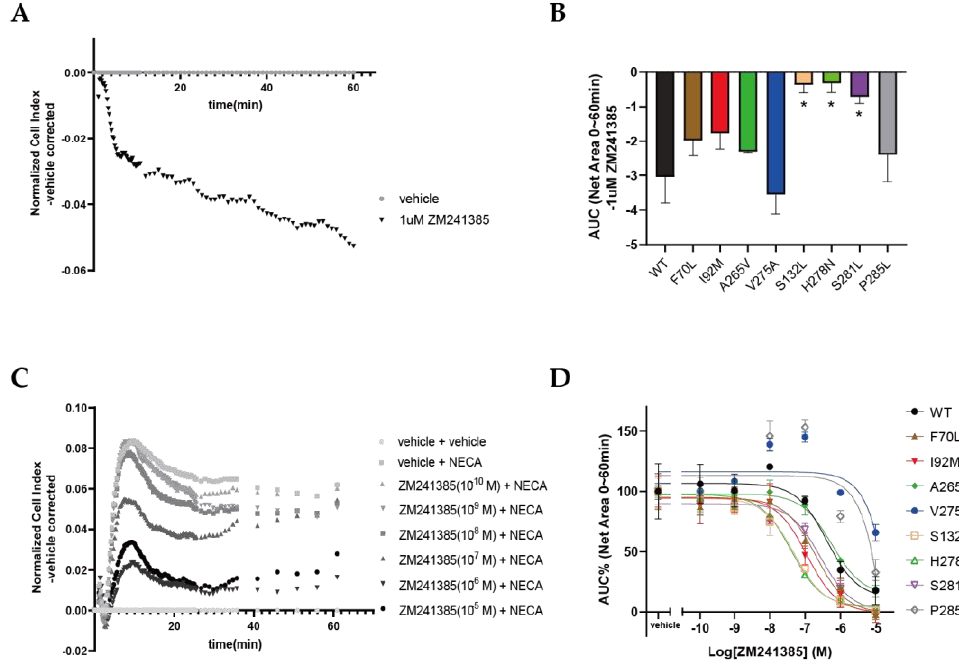
Figure 6. Functional characterization of wild-type and mutant A 2A ARs with inverse agonist ZM241385 in transiently transfected HEK293T cells, using a label-free impedance-based cell-morphology assay. ( A ) Representative time trace of the normalized cell index of WT-A 2A AR-expressing HEK293T cells stimulated with 1 µ M ZM241385. ( B ) Area under the curve within 60 min after ZM241385 treatment was used to quantify its inverse agonism for A 2A ARs. Data are shown as mean ± SEM of three independent experiments performed in duplicate. Significant difference from the WT-A 2A AR is shown as * p < 0.05; ordinary one-way ANOVAs with Dunnett’s multiple comparisons tests. ( C ) Representative graph of normalized cell index of different concentrations of ZM241385 with respect to NECA-stimulated wild-type A 2A AR. Vehicle was used for baseline correction. ( D ) Concentration–response curves of ZM241385 for wild-type and mutant A 2A ARs derived from the area under the curve within 60 min after NECA addition. Response to vehicle was normalized to 0%, and response to EC 80 of NECA after pretreatment with vehicle was normalized to 100%. Data are shown as mean ± SEM of three independent experiments, each performed in duplicate. Table 3. Quantification of the inverse agonism of ZM241385 on A 2A ARs and the inhibitory potency of ZM241385 on NECA stimulation.